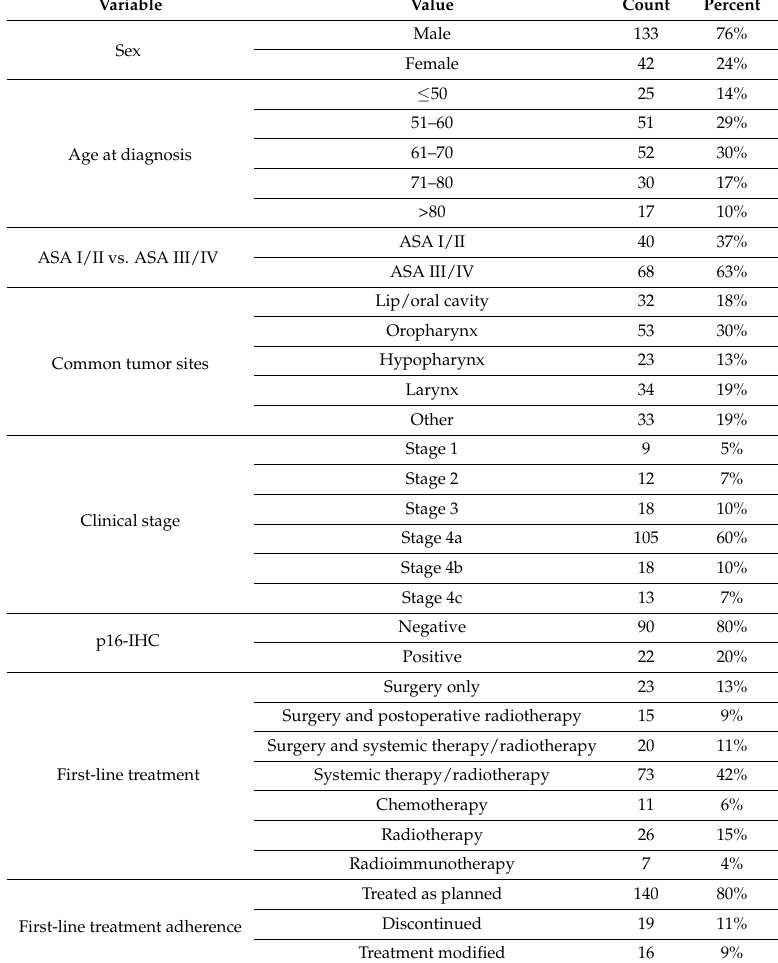
Table 1. Characteristics of 175 patients with persistent HNC after first-line treatment. All patients with incident HNC treated between 2008 and 2016 were consecutively included. To assess first-line treatment response, patients received a thorough diagnostic re-evaluation 8–10 weeks after completion.